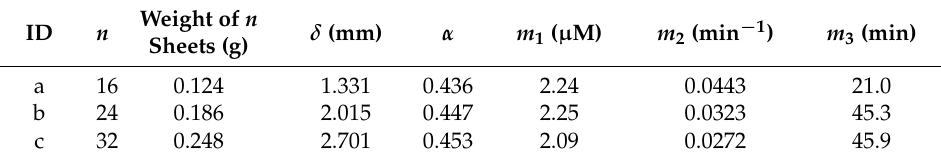
Table 1. Thickness δ and porosity α of samples with n sheets and related parameters 1 of methylene blue elution.